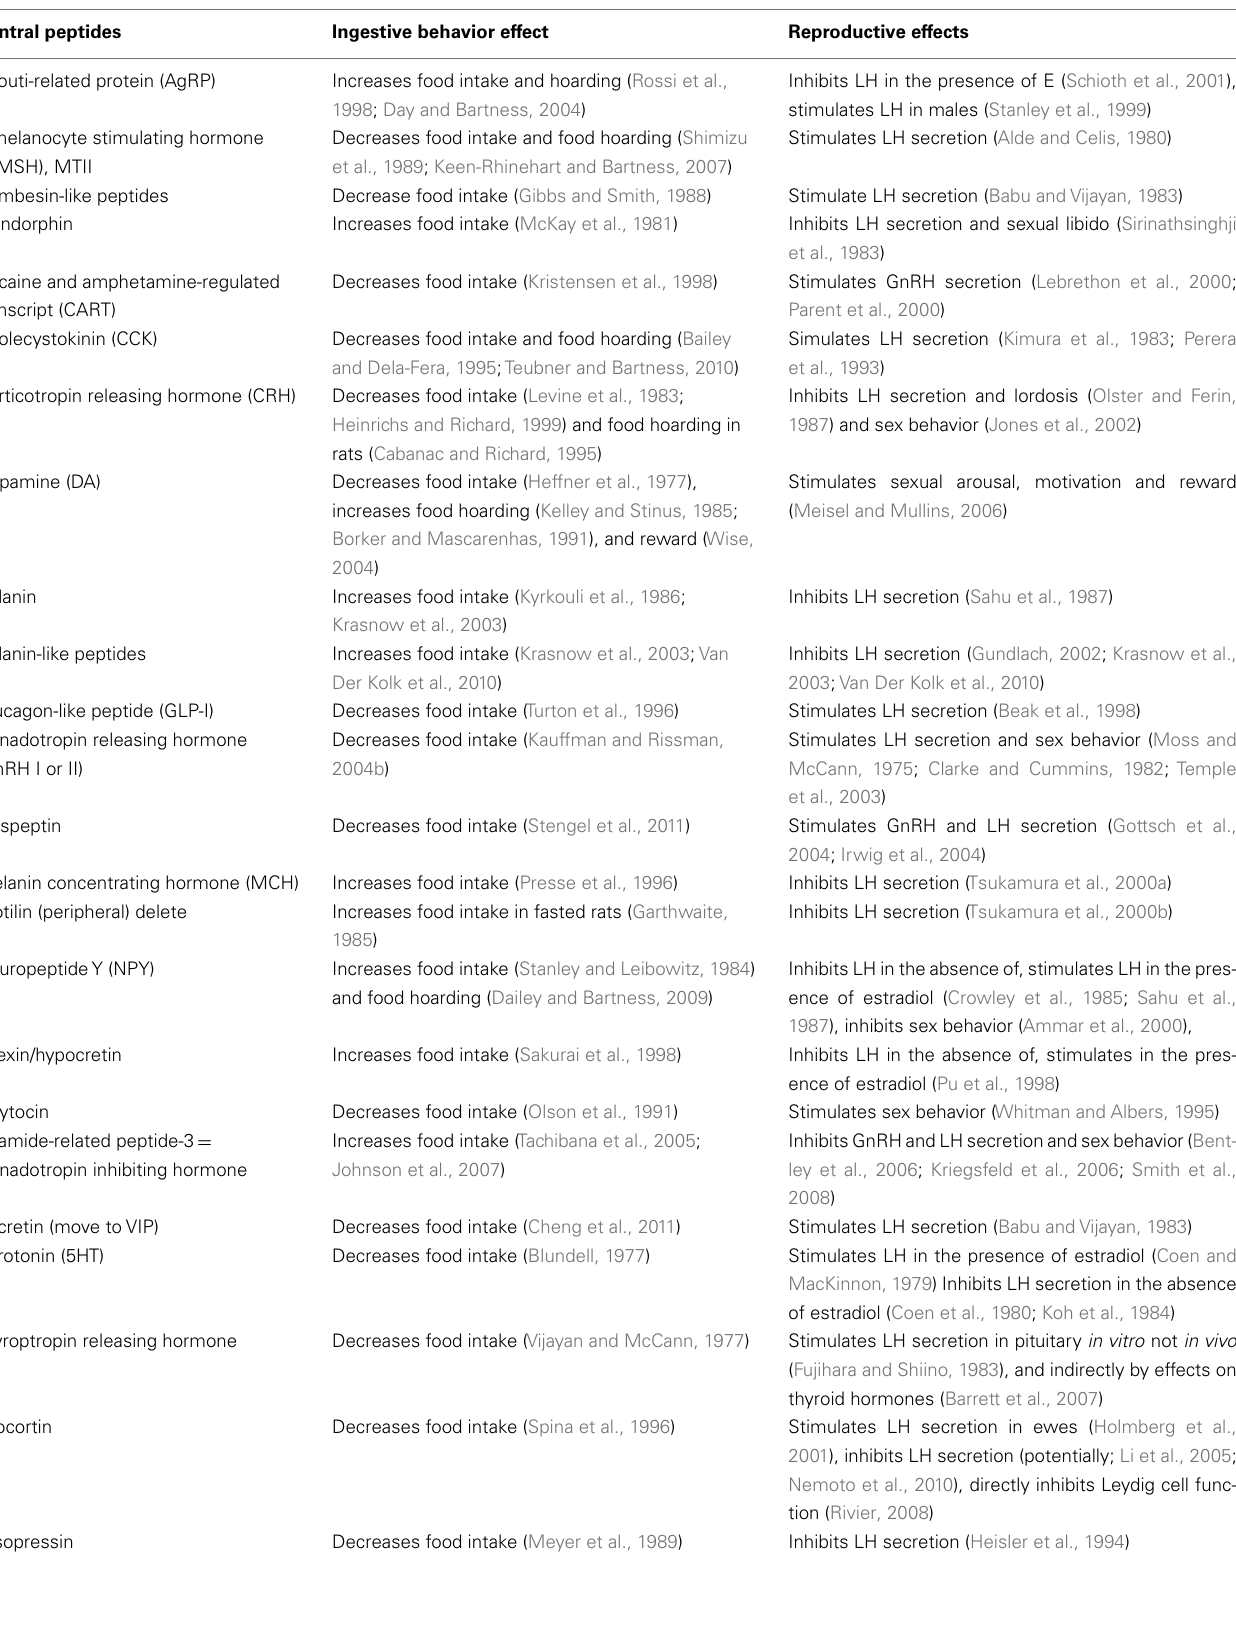
Table 1 | Orexigenic and anorectic peptides that influence